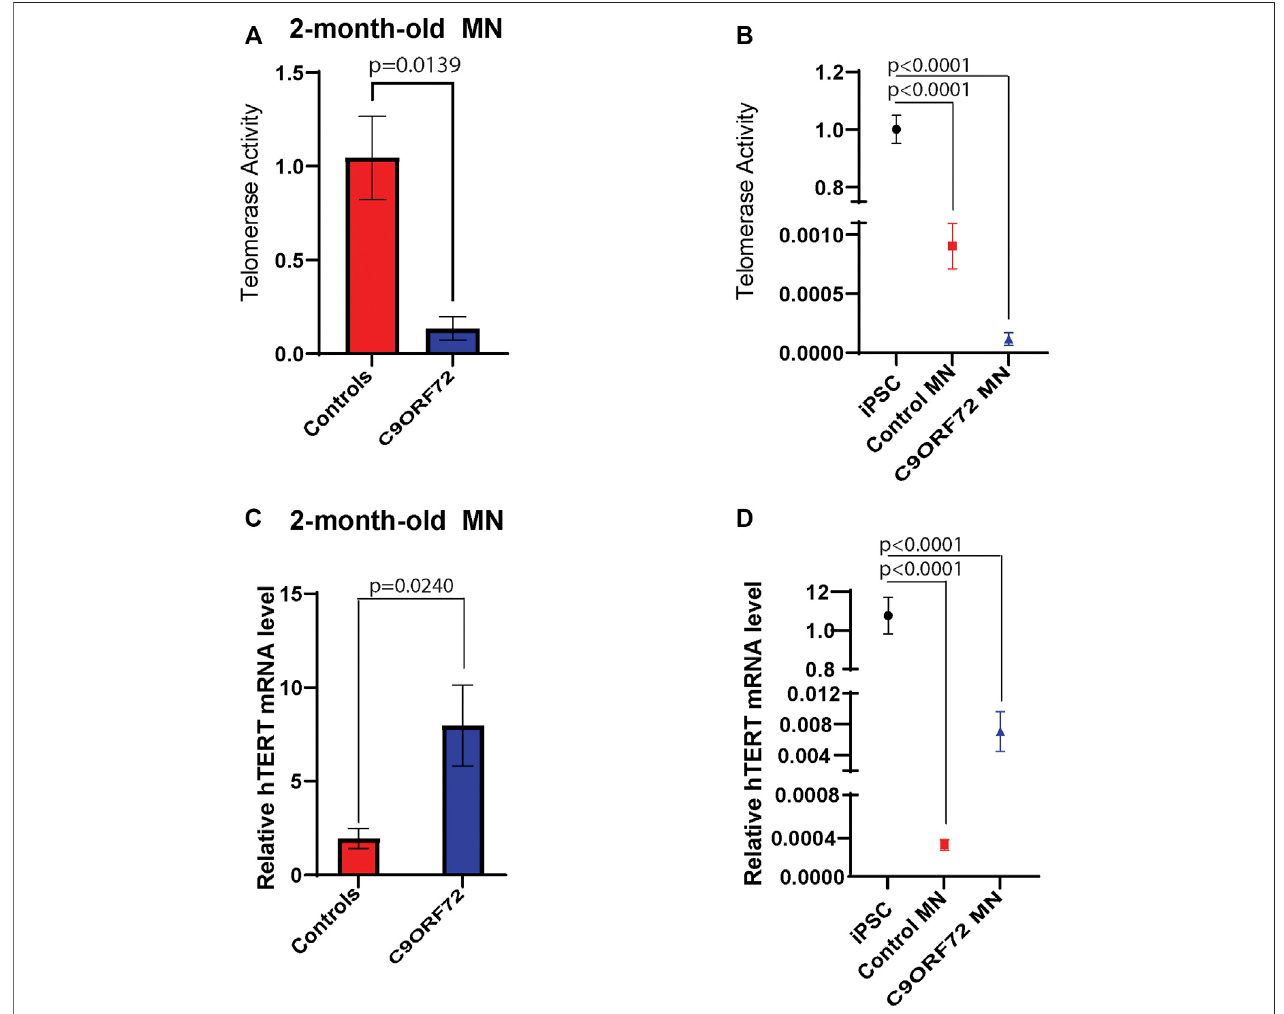
FIGURE 6 | Telomerase activity and hTERT mRNA levels in 2 month-old-motor neurons. qPCR analyses of relative levels of telomerase activity in (A) 2 month-old iPSC-derived MNs from 3 control and 3 C9ORF72 carriers, (B) relative levels of telomerase activity in iPSC lines and 2 month-old iPSC-derived MNs from 3 control and 3 C9ORF72 carriers.qPCRanalysisoftherelativelevelsofhTERTin (C) 2-month-oldiPSC-derivedMNsfrom3controlsubjectsor3 C9ORF72 carriers, (D) relativelevels of hTERT iniPSC lines and 2 month-oldiPSC-derived MNs from 3controland 3 C9ORF72 carriers. Two-tailed t -test with Welch ’ scorrectionto compare between controls and C9ORF72 MNs and a one-way ANOVA to compare iPSC to iPSC-derived MNs cultures.